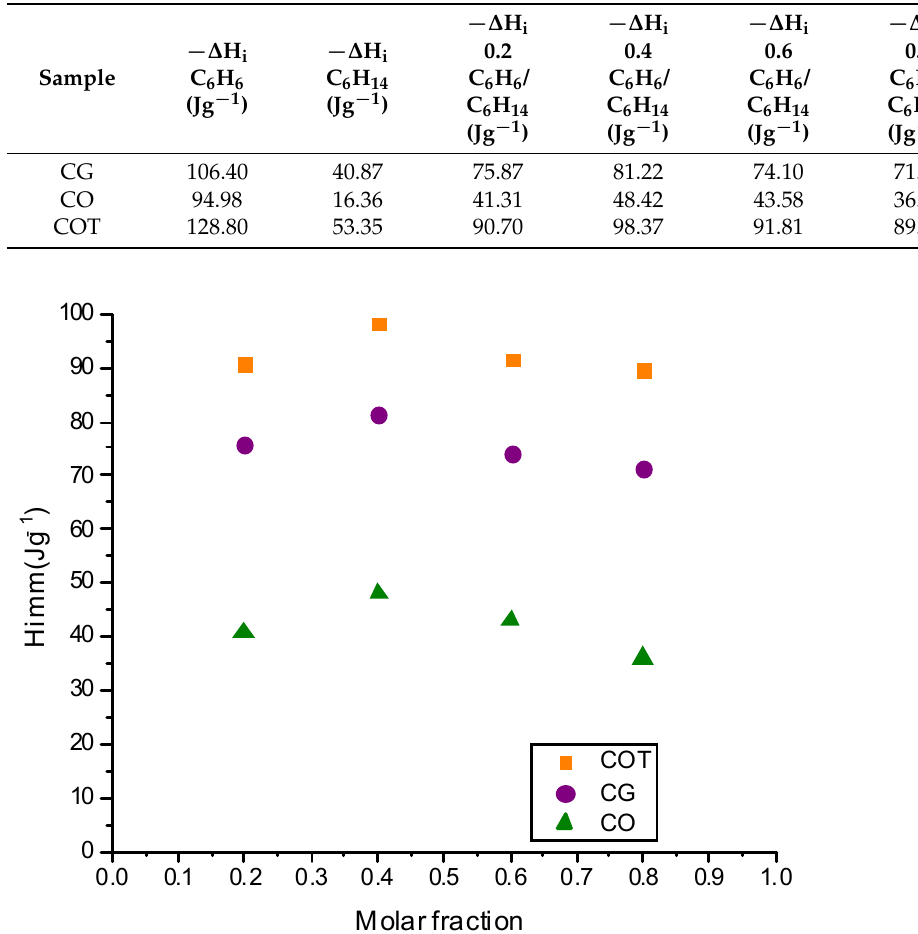
Figure 7. Enthalpies of immersion of samples in binary mixtures as a function of mole fraction.